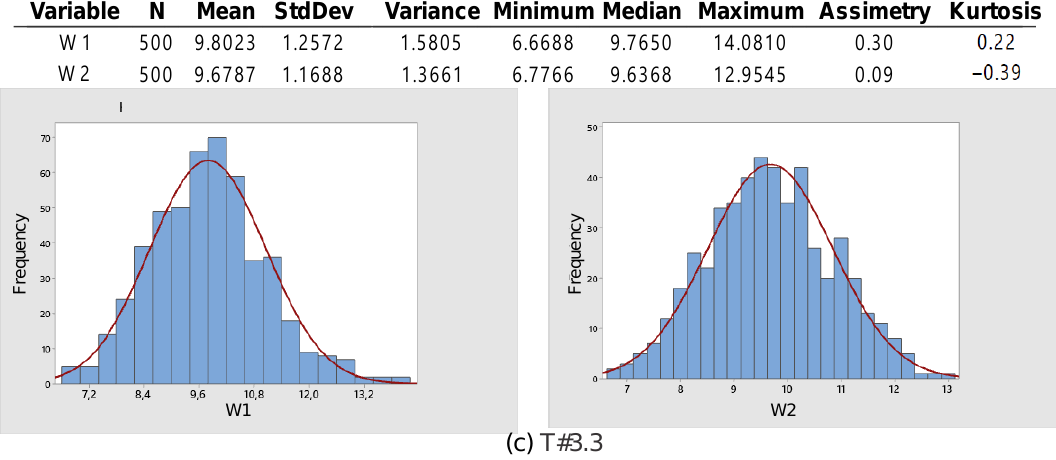
Figure 26. Basic descriptive statistics applied to data obtained during the trial sessions carried out on firm soil with the slip automatically adjusted by the proposed control